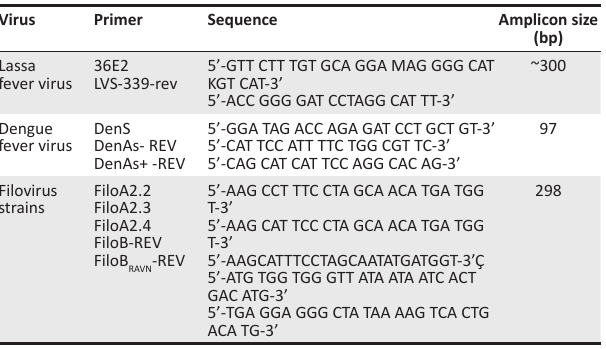
TABLE 1: Primers used in the laboratory investigation of viral haemorrhagic diseases. Virus Primer